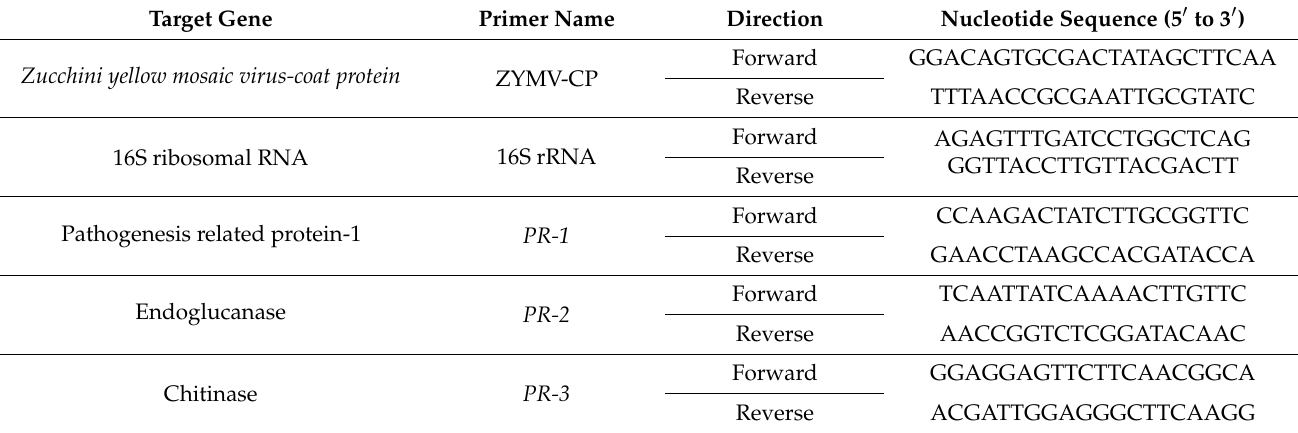
Table 1. Nucleotide sequences of primers used in this